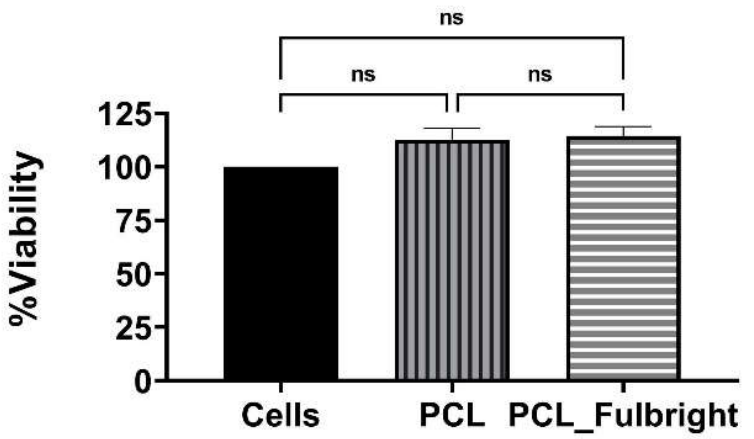
Figure 7. Cytotoxicity assay against Balbc/3T3 mouse embryo fibroblast cell line. ns = no sign- ificant difference.